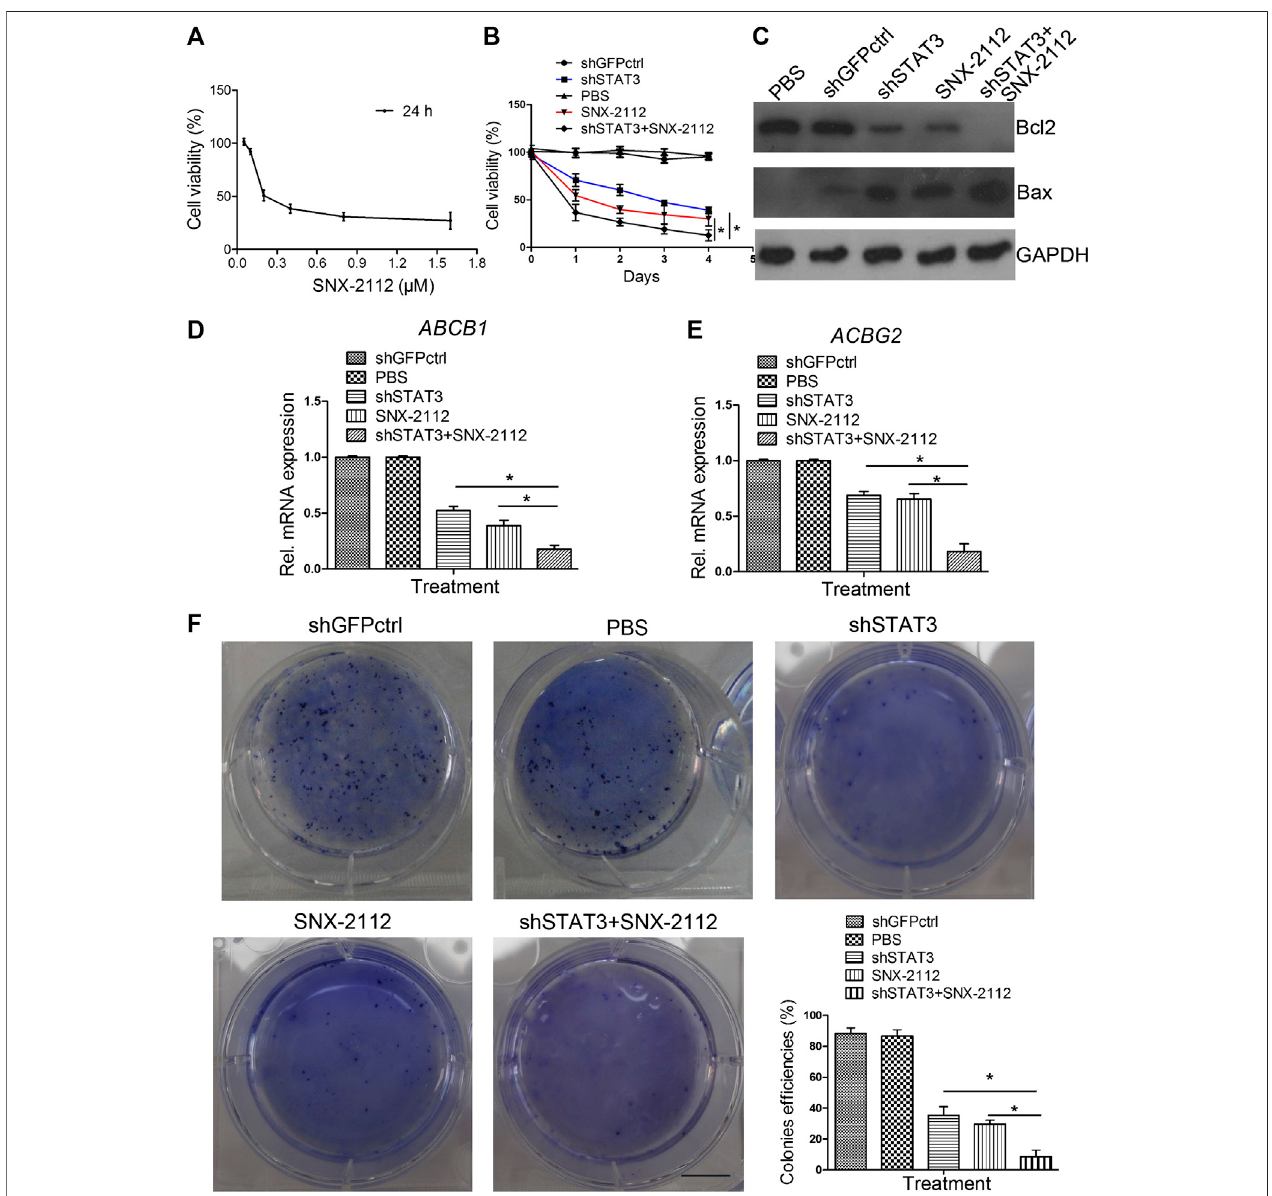
FIGURE 3 | The inhibition of colony formation capacity of ECSLCs by combination treatment of SNX-2112 with shSTAT3 (A) Cell viability of ECSLCs treated with SNX-2112 for 24 h. ECSLCs were treated with various concentrations of SNX-2112 fro 24 h and cell viability was assessed using the MTT assay. (B) Proliferation curve analysisofECSLCsaftertreatmentwithSNX-2112andshSTAT3.ECSLCswerestablytransducedwithlentiviralconstructscarryingshGFPctrlandshSTAT3.After72 h, ECSLCs were treated with 0.2 μ M SNX-2112 for 24 h. Then, ECSLCs proliferation was evaluated by MTT assay. The experiments were repeated three times independently. (C) Western blot analysis of Bcl2 and Bax expression levels in ECSLCs post treatment with shSTAT3 for 72 h and 0.2 μ M SNX-2112 for 24 h. GAPDH wasusedasaloadingcontrol. (D,E) qPCRanalysisof ABCB1 and ABCG2 inECSLCs.AftertransfectionwithshSTAT3for72 h,ECSLCsweretreatedwith0.2 μ MSNX- 2112 for 24 h. Vertical bars represent mean ± SD. (F) The colony forming capacity of ECSLCs was tested using soft agar plates. Approximately 1 × 103 ECSLCs post treatment with shSTAT3 and 0.2 μ M SNX-2112 were allowed to grow for approximately 14 days and formed colonies were stained by 0.5% crystal violet and counted. The experiments were repeated three times independently. Scale bar, 10